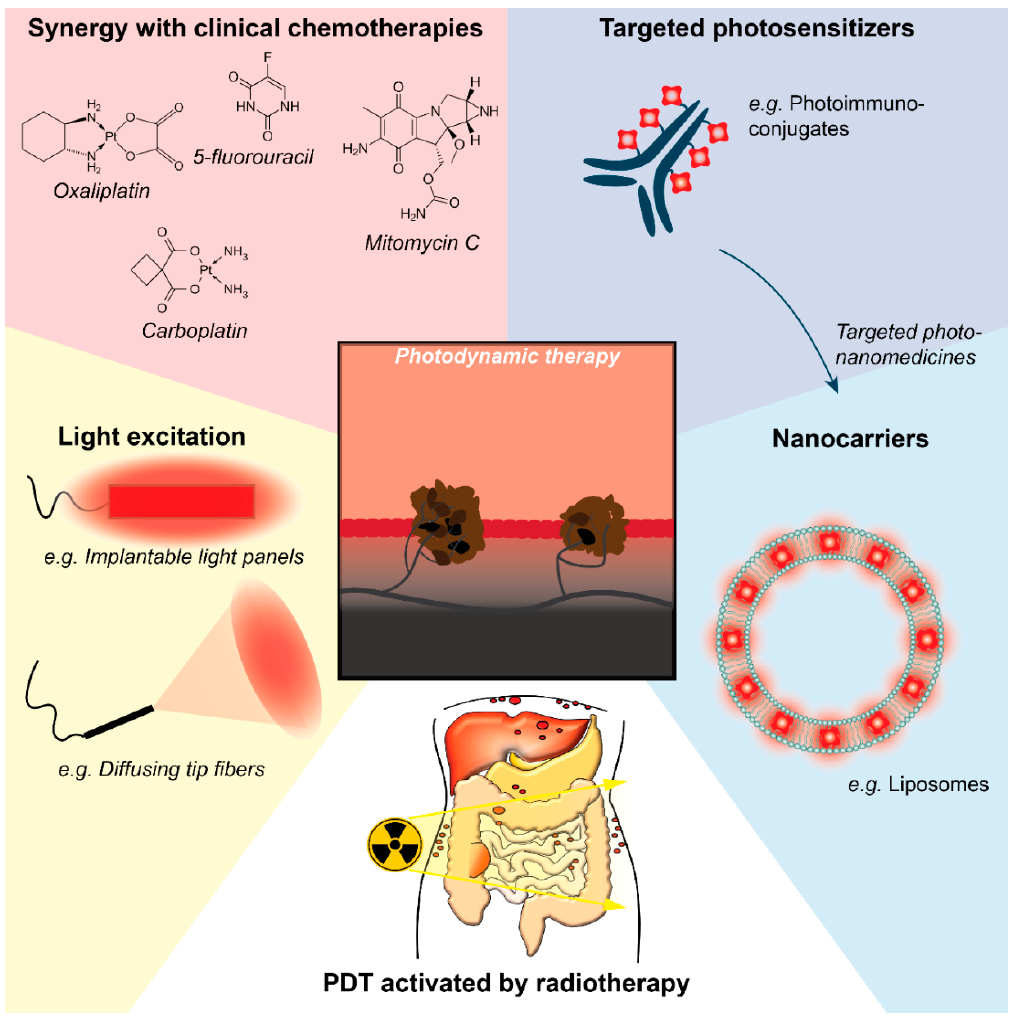
Figure 3. Promising strategies to improve the efficacy of PDT for PCAR. Promising results from the application of PDT for PCAR have been achieved using innovative photoimmunoconjugates and photosensitizer-loaded nanocarriers, which can in principle be combined to develop targeted photonanomedicines. Regarding the integration into the clinical practice, PDT may synergize with clinical chemotherapies, and innovative lighting solutions (e.g., implantable light panels and diffusing tip laser wands) may aid in improving the efficacy of PDT for PCAR. To overcome the difficulty of reaching occult PCAR with light, radiotherapy-activated PDT may be a promising solution.